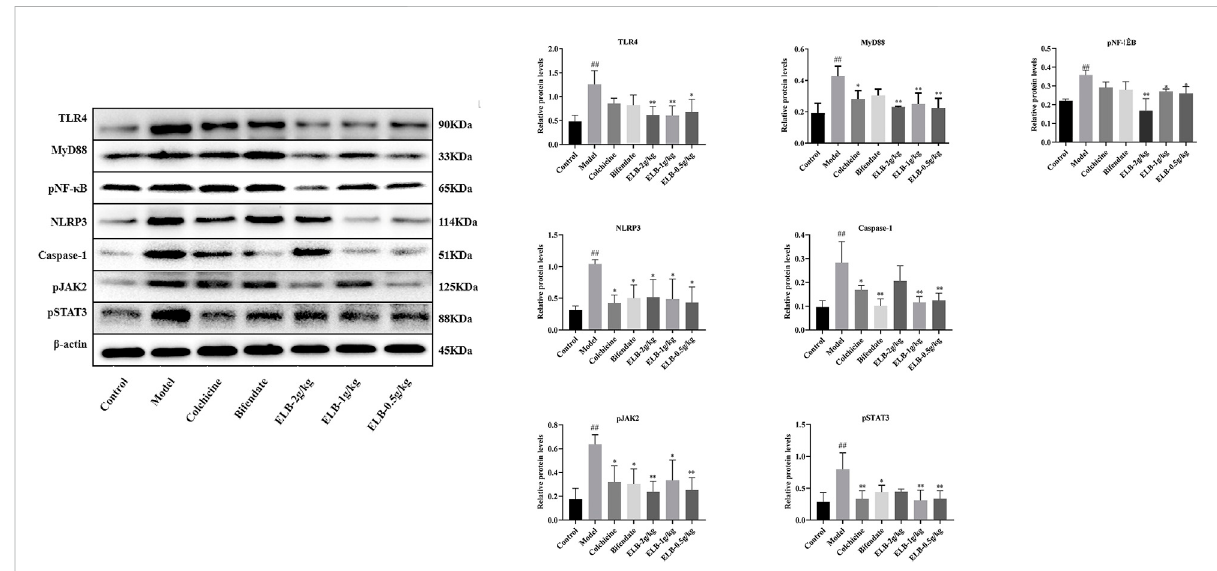
FIGURE 4 EffectsofELBonproteinlevelsofTLR4,MyD88,pNF- κ B,NLRP3,caspase-1,pJAK2,andpSTAT3intheliverofaratmodelwithchronicalcoholic liver injury and gouty arthritis. Note: compared with control group, # p < 0.05, # # p < 0.01; Compared with the model group * p < 0.05, * * p <